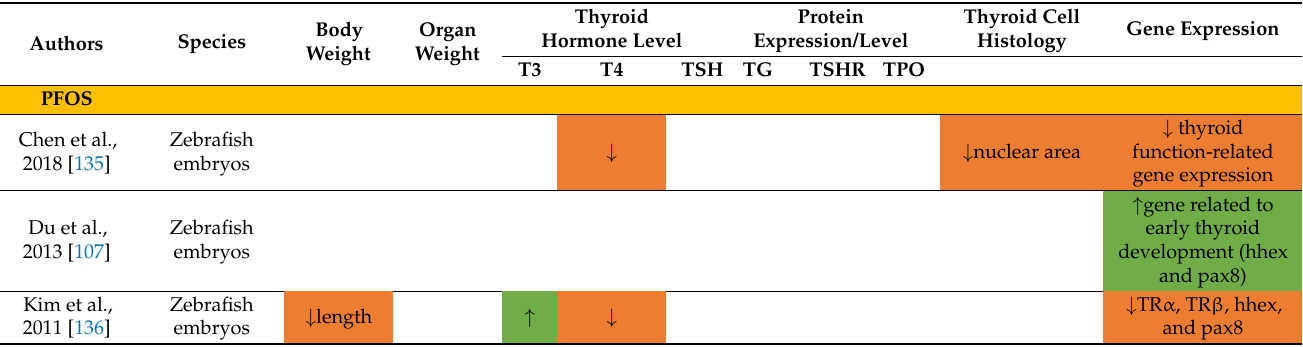
Table 10. In vivo results related to PFAS exposures and thyroid hormone